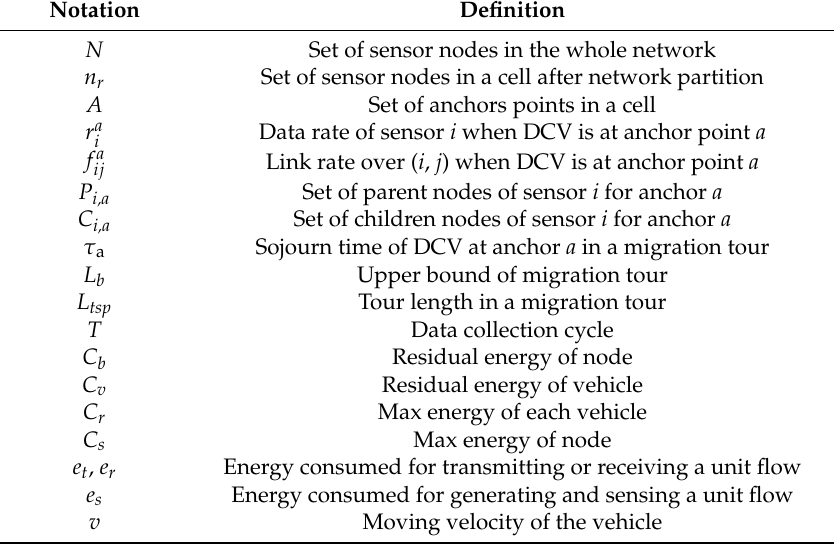
Table 1. List of